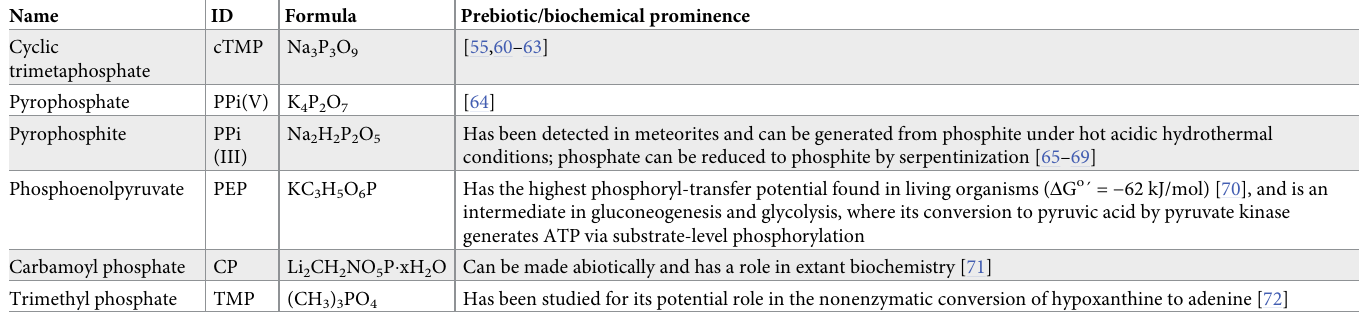
Table 1. Phosphorylating agents